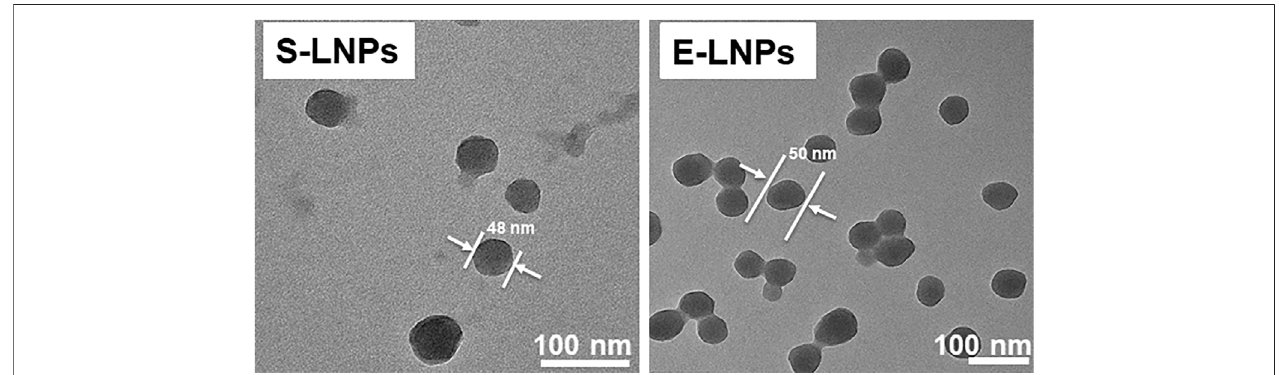
FIGURE 4 | E-LNPs demonstrate the presence of higher numbers of carbohydrates on their surfaces as measured by liquid-state 1 H NMR in aqueous suspensions.NMRrevealedparticulardifferencesinchemicalstructurespresentonthesurfaceofS-andE-LNPs:signalscorrespondingtocarbohydratesandaromatic units were more pronounced in E-LNPs, whereas S-LNPs demonstrated more intense signal for nonpolar aliphatic side chains of lignin.